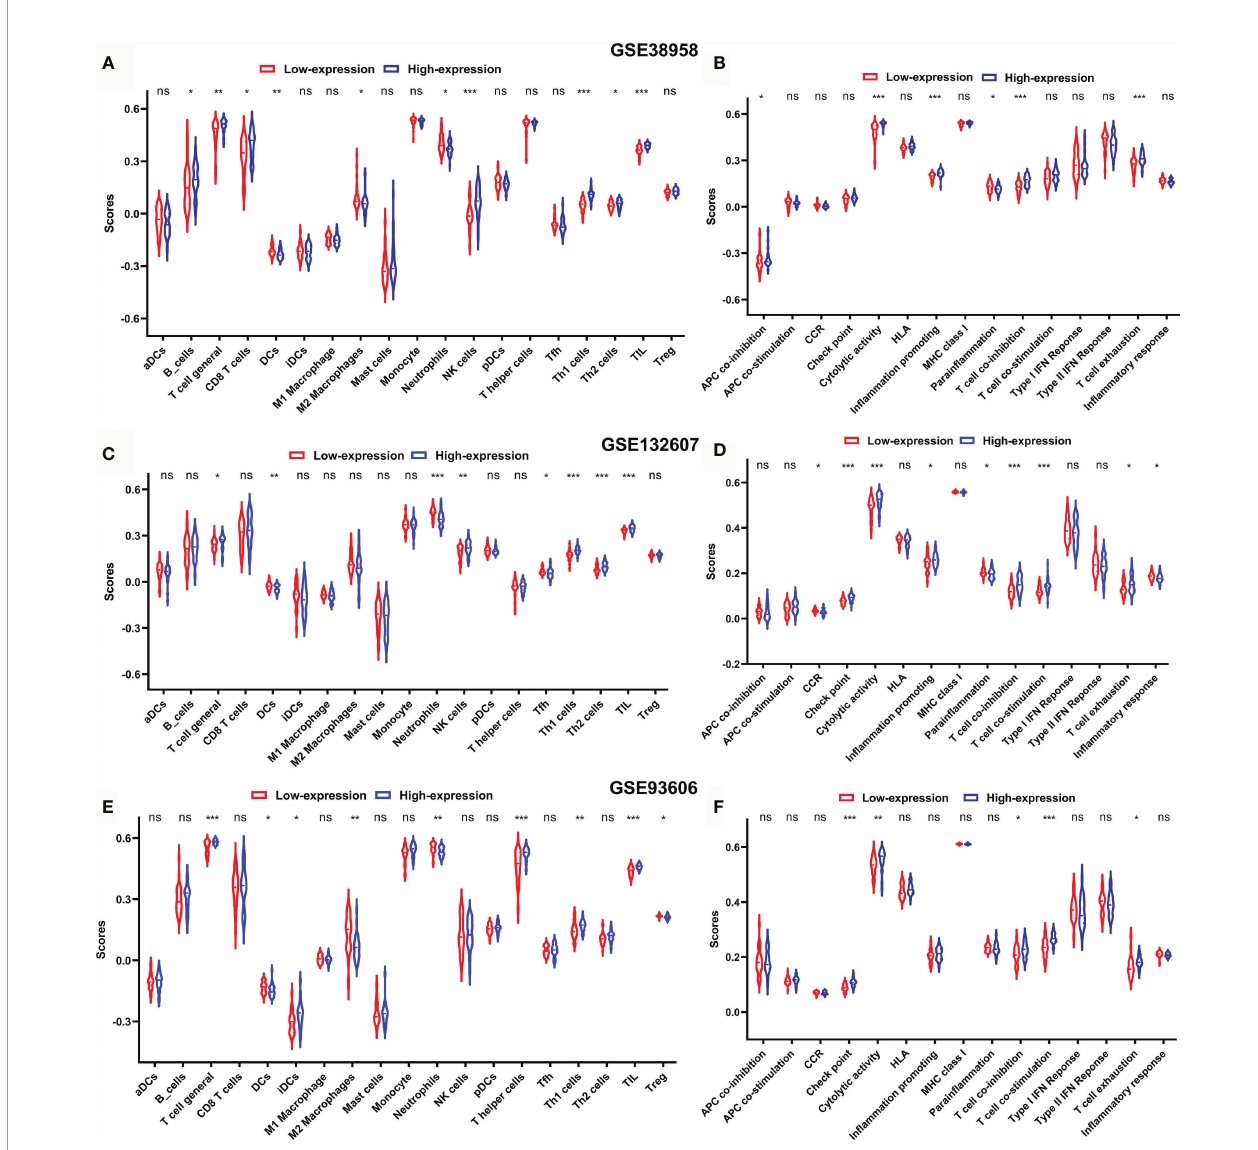
FIGURE 8 | Comparisonofthe ssGSEA scores between patients with low-expression CD247 andpatients with high-expression CD247 in the GSE38958 dataset (A, B) , GSE132607 dataset (C,D) , and GSE93606 dataset (E, F) . The scores of 19 immune cells (A, C, E) and 15 immune-related functions (B, D, F) are displayed in violin plots. DC, dendriticcell; TIL,tumor-in fi ltrating lymphocytes; CCR,cytokine – cytokine receptor. P values were shownas: ns, not signi fi cant; *p< 0.05; **p < 0.01; ***p <